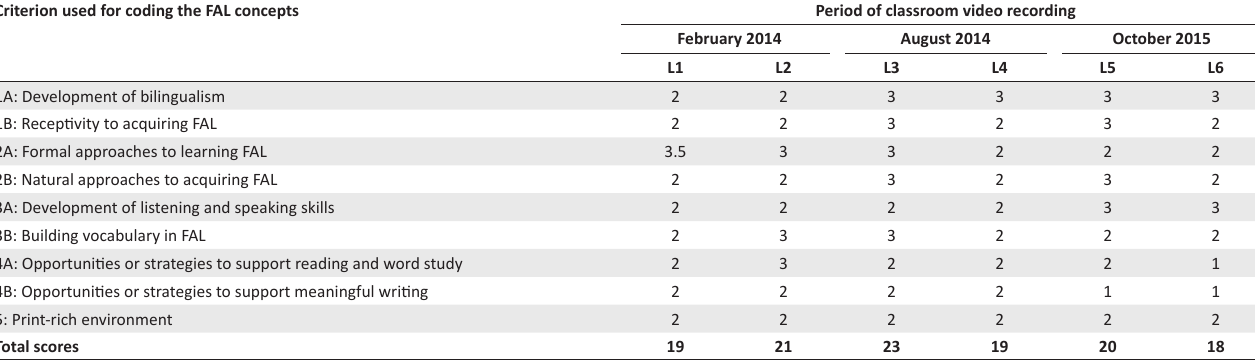
TABLE 5: The extent to which Jane’s practice reflects the principles of teaching English as a First Additional Language. Criterion used for coding the FAL concepts